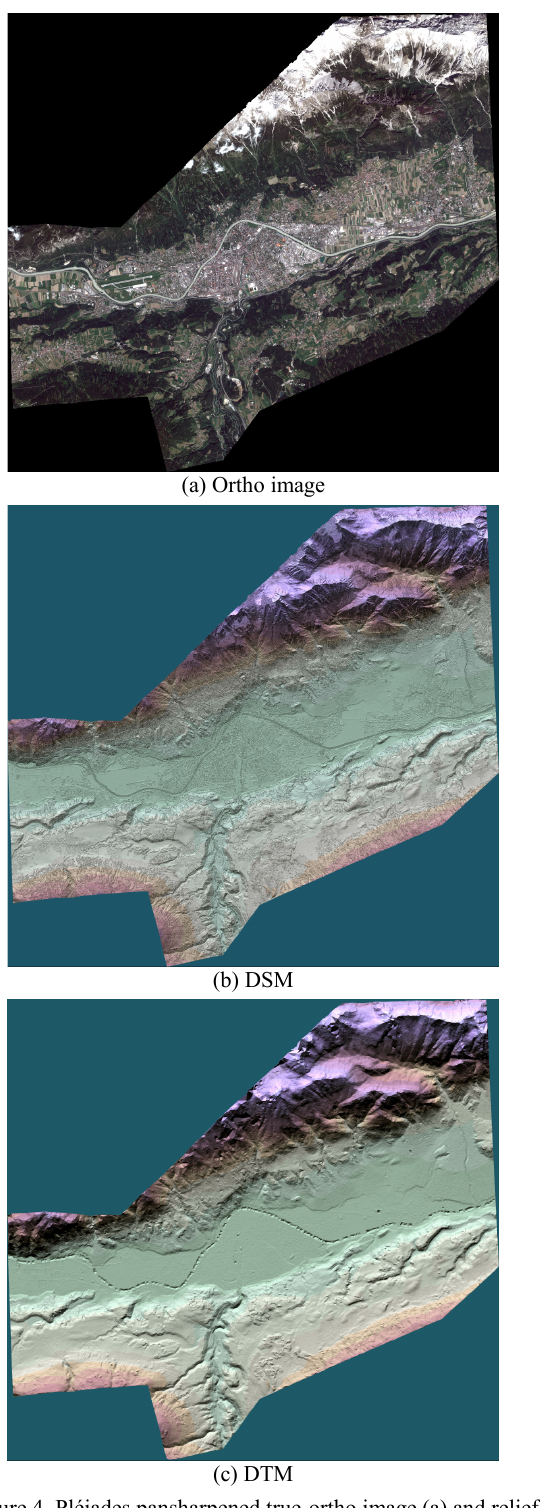
Figure 5. Subset of true-ortho image and input DSM together with ground masks using different filtering